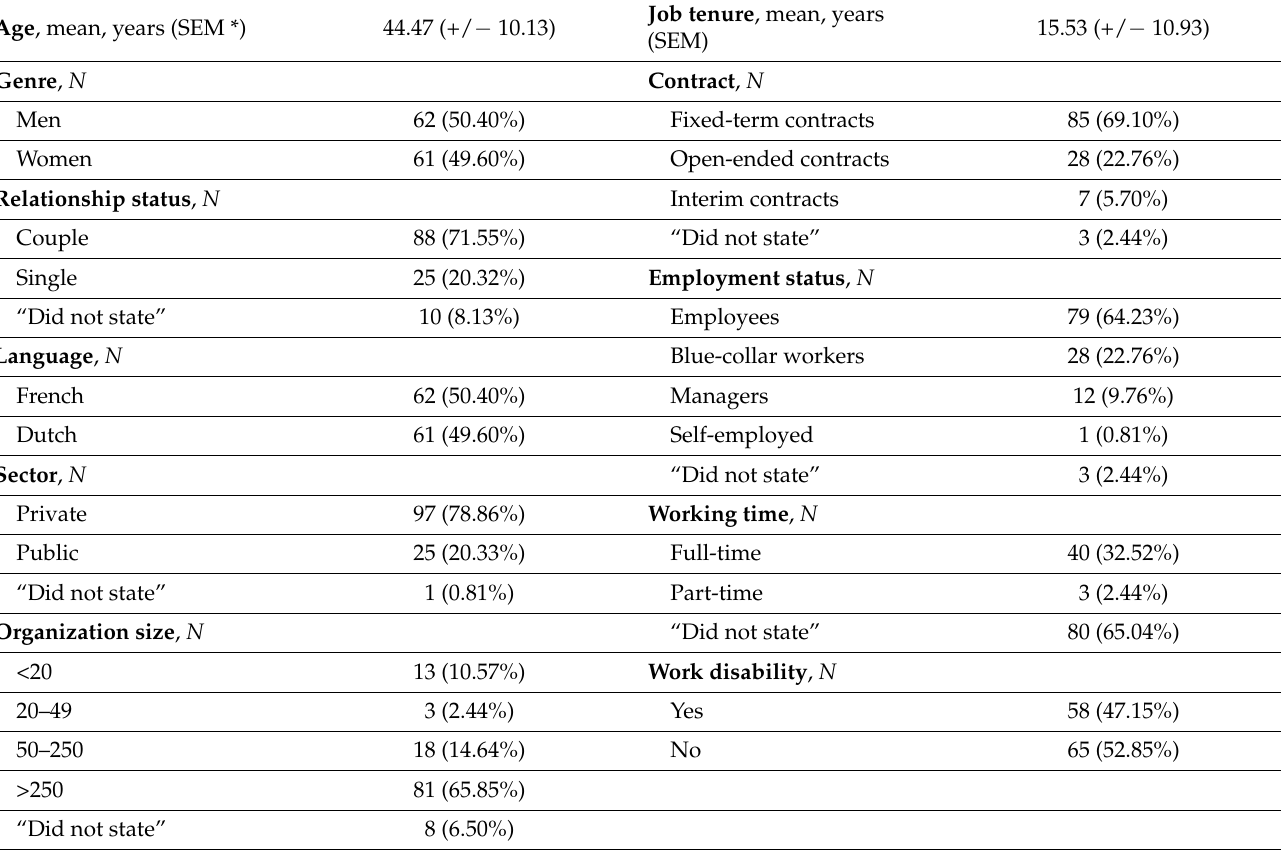
Table 2. Subject demographics, N =